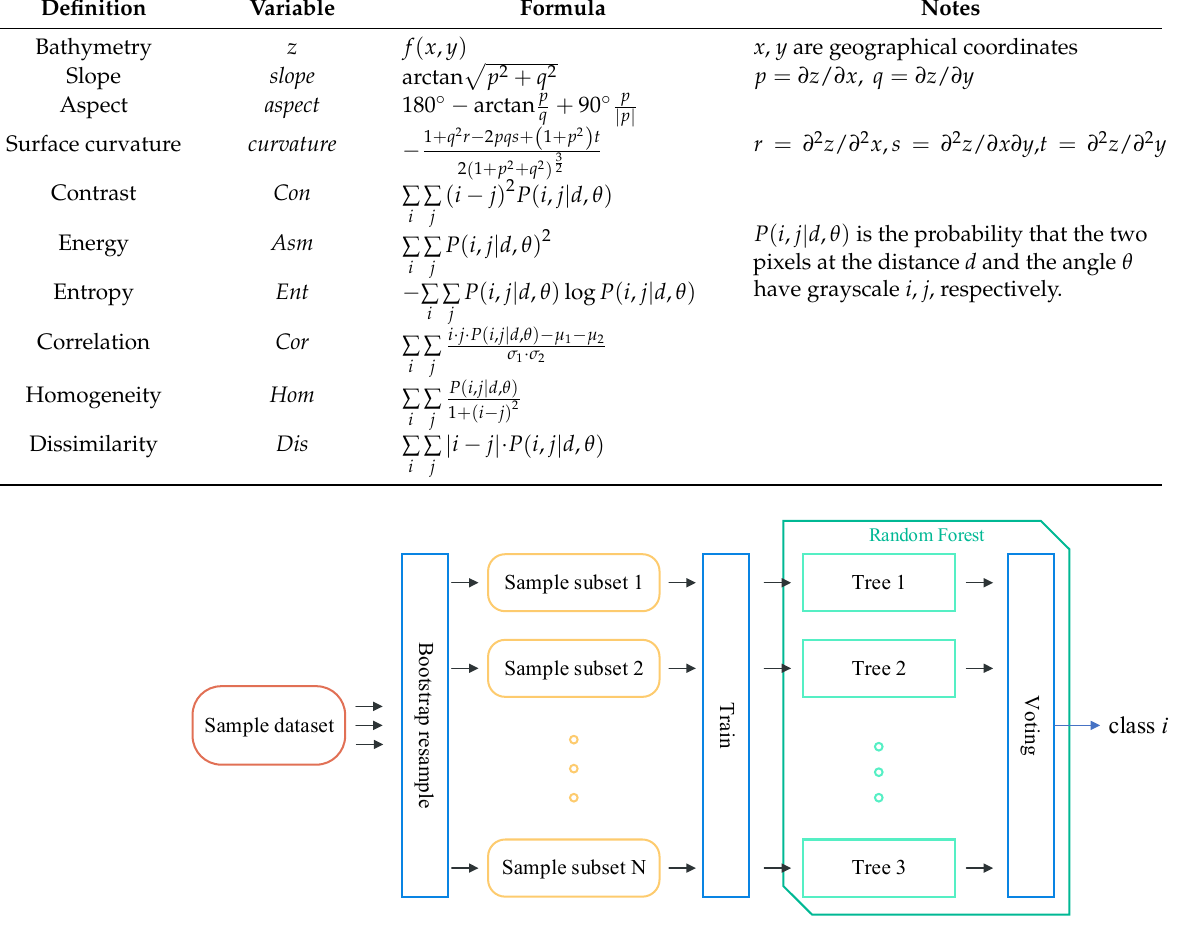
Figure 4. The procedure of RF generation.